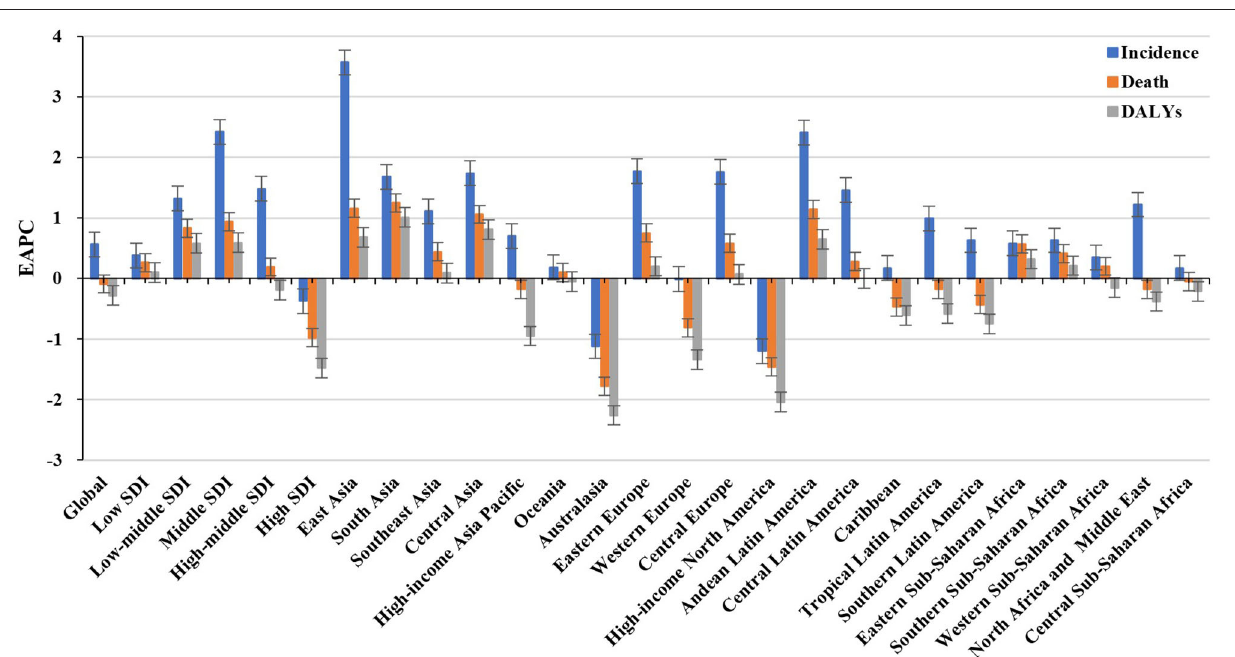
in which the respective EAPCs were 3.57 (95% CI: